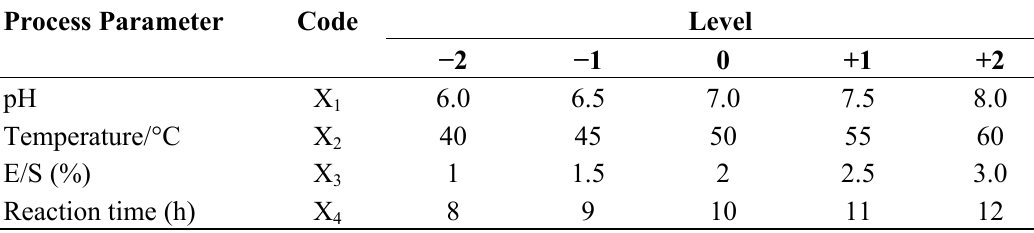
Table 3. Coded and uncoded setting of the process